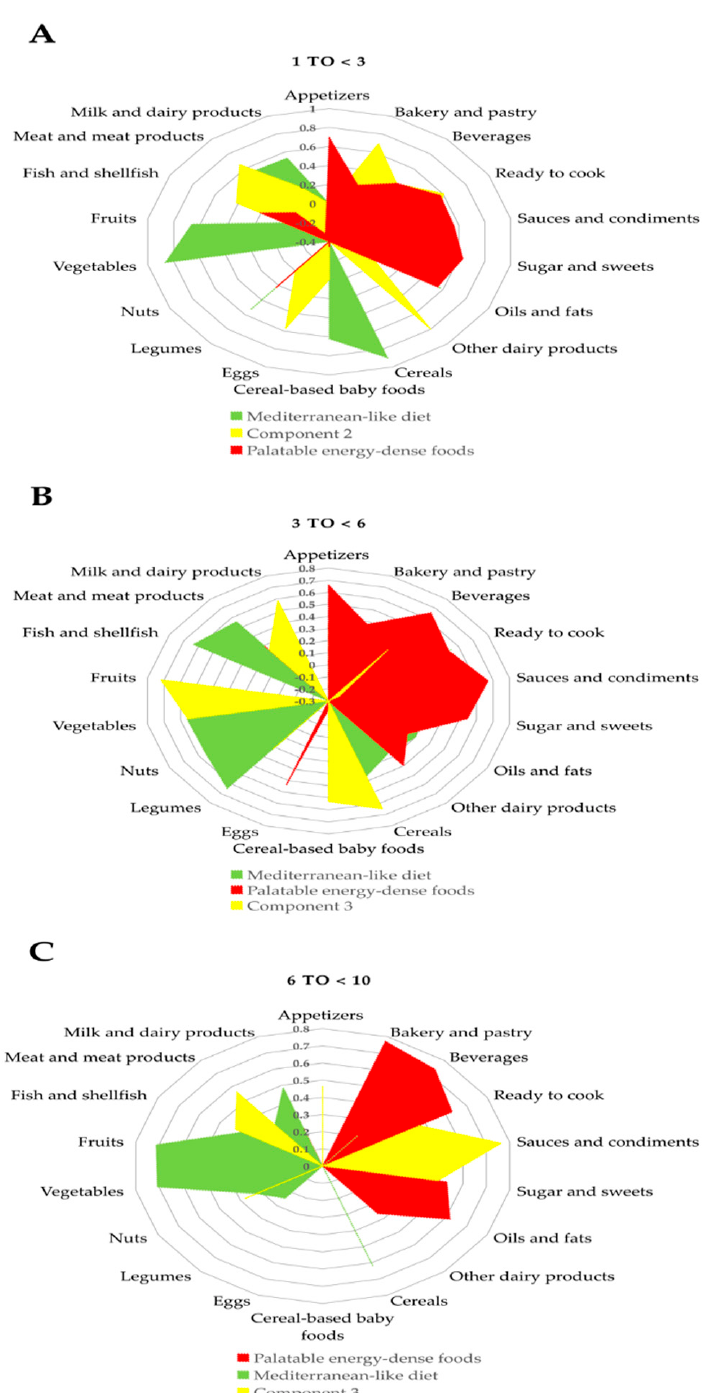
Figure 2. Dietary patterns extracted from the principal component analysis of 18 major food groups in a sample of adapted milk consumers cohort (AMS) for the EsNuPI ( n = 772): ( A ). Children from 1 to < 3 years ( n = 302), ( B ). children from 3 to < 6 years ( n = 277), and ( C ). children from 6 to < 10 years ( n = 193).